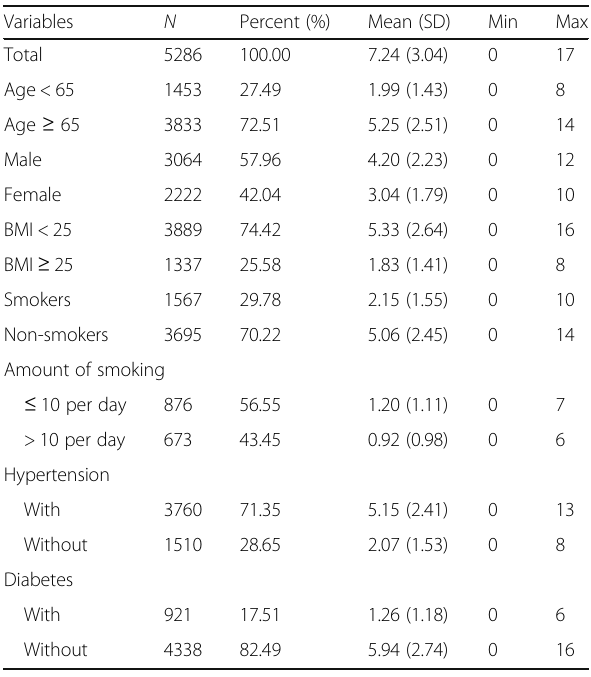
Table 1 Summary statistics of fatal ICH events by age, gender, BMI, smoking status, amount of cigarette smoking, and comorbid conditions in Shanghai, China, from 1 June 2012